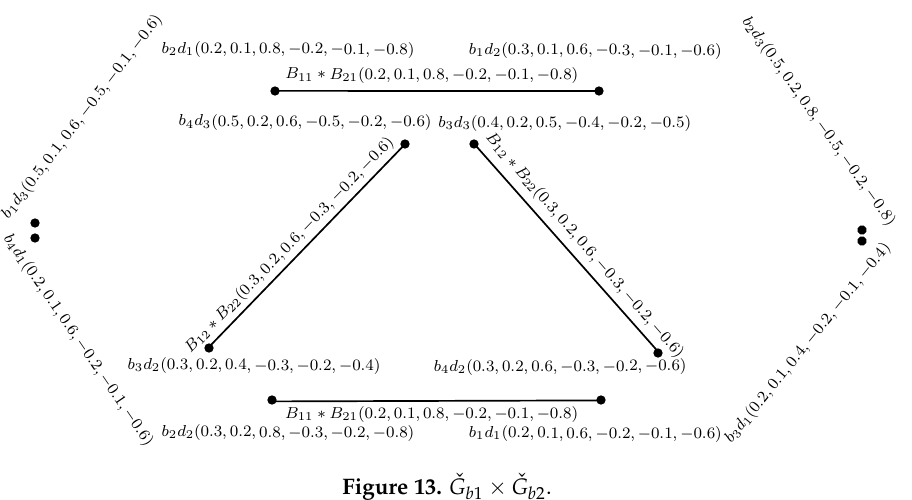
Figure 13. ˇ G b 1 × ˇ G b 2 Figure 2.13: ˇ G b 1 ∗ ˇ G b 2